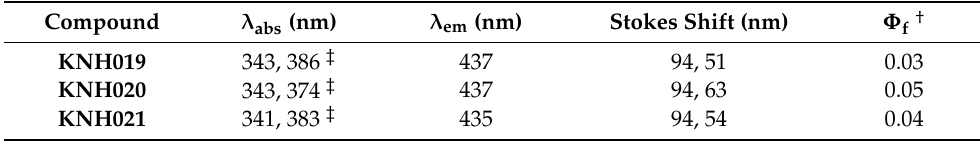
Table 2. Photophysical properties of 3-amido scriptaid analogues in DMSO.